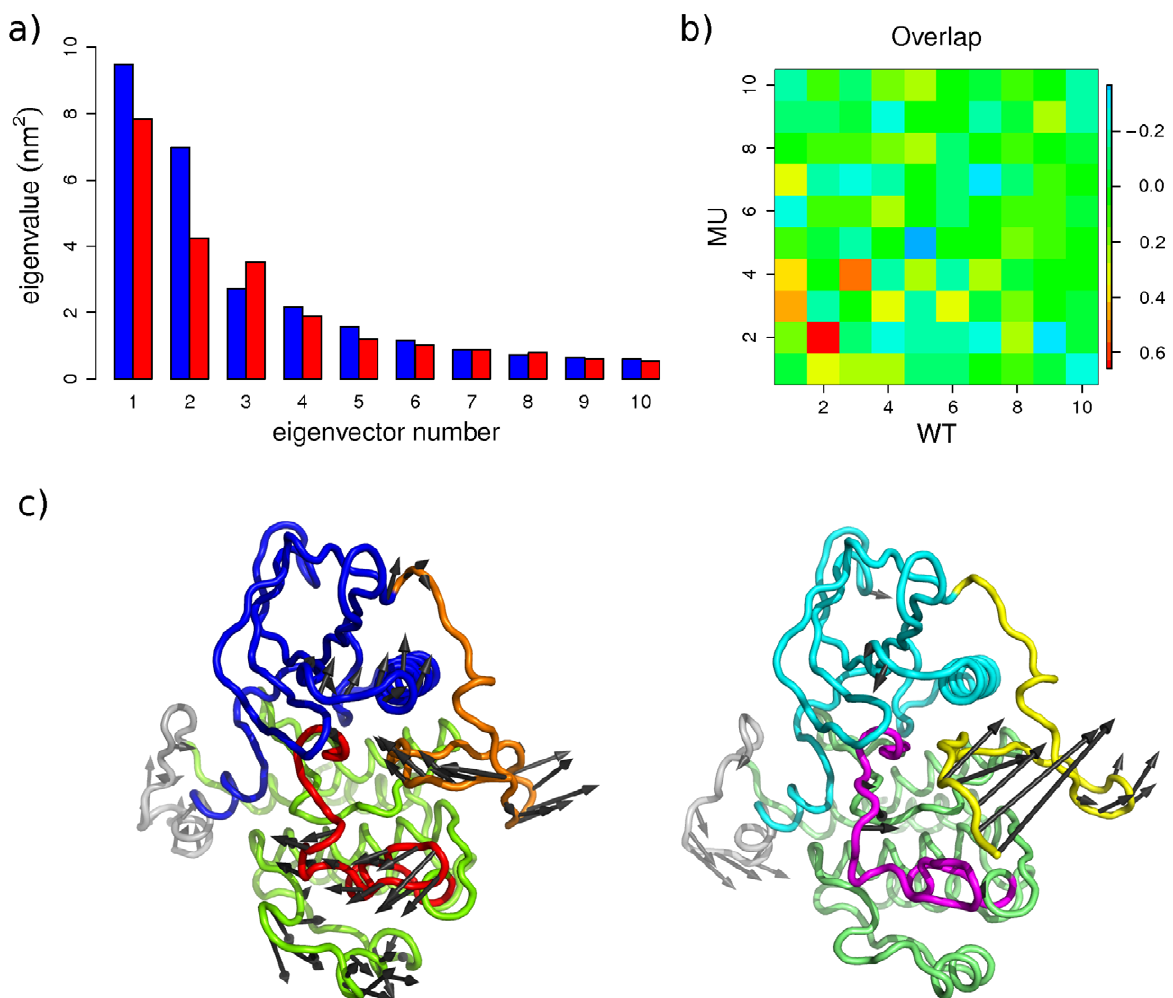
Figure 6. Principal component analysis of KIT cytoplasmic region motions in the auto-inhibited inactive form. The calculation was performed on the backbone atoms of WT 547-935 and MU 547-935 , combining the MD trajectories 1 and 2 (total of 96-ns productive simulation time) and taking the average MD conformations as references for the RMS fits. Top : ( a ) The barplot gives the eigenvalues spectra of wild-type (in blue) and mutant (in red), in descending order. ( b ) The grid gives the overlaps between eigenvectors from wild-type (columns) and mutant (rows). The overlap or similarity between two eigenvectors is evaluated as their scalar product and represented by a colored rectangle, from blue ( 2 0.7) though green (0) to red (0.7). Bottom : ( c ) Modes 2 atomic components for wild-type (left panel) and mutant (right panel) are drawn as dark grey arrows on the protein cartoon representation. JMR is in orange (WT) and yellow (MU), N-lobe is in green (WT) and lime (MU), A-loop is in red (WT) and magenta (MU), C-lobe is in marine (WT) and cyan